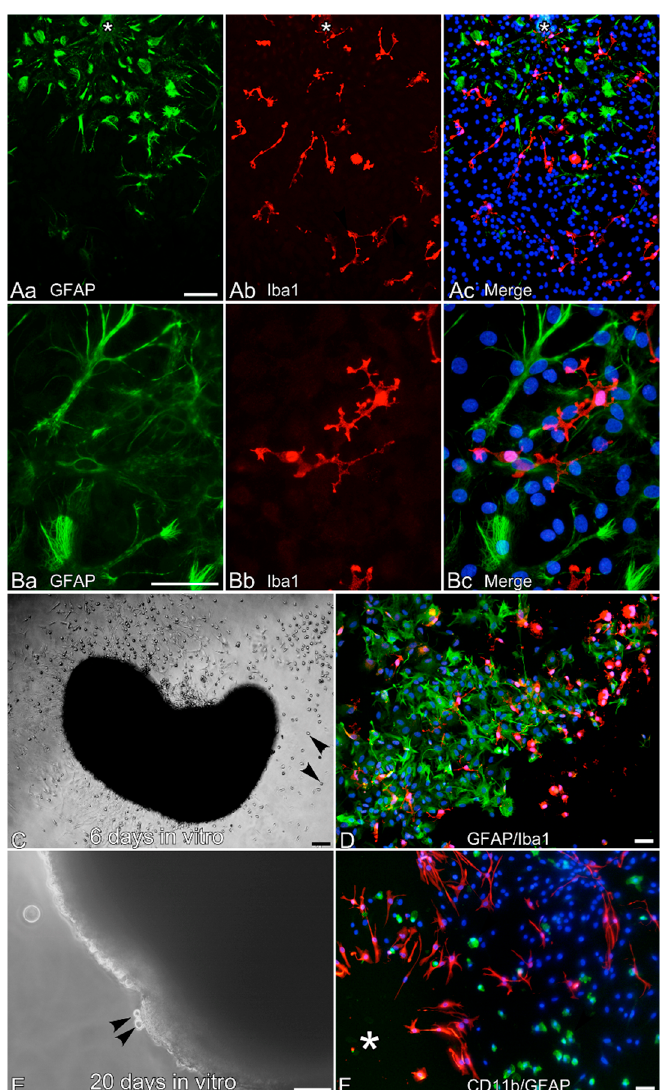
Figure 3. Generation of Iba1 + ramified microglia-like cells from leptomeningeal cells on poly-L-lysine (PLL) ‐ coated glass coverslips in Dulbecco’s modified Eagle ′ s medium containing 10% fetal calf serum (FCS-DMEM). ( A , B ) GFAP + cells (green) and Iba1 + ramified microglia-like cells (red) generated from aggregates in dissociated culture maintained in E2-EGF for 4 days. The cells were fixed and immunostained after the aggregates were cultured for 2 days in FCS-DMEM. Nuclei were stained blue by Hoechst 33258. Asterisks in ( A ) denote the place where an aggregate loosely attached before fixation. The aggregates detached during fixation, and GFAP + and Iba1 + cells migrated out of the aggregates. ( C , D ) En bloc culture of leptomeninges-generated Iba1 + cells as well as GFAP + cells. ( C ) A phase contrast micrograph shows that a large number of cells migrated out of a rounded piece of meninge cultured for 6 days in E2-EGF. Many amoeboid cells (arrowheads) came out and migrated a long distance. ( D ) Ramified, amoeboid Iba1 + cells (red) and GFAP + cells (green) generated from the rounded leptomeninges. Nuclei were stained blue by Hoechst 33258. ( E ) A piece of leptomeninges cultured for 20 days in E2-EGF still produced macrophage-like cells budding from the surface of the leptomeninges (arrowheads). ( F ) Cells derived from the cultured tissue were fixed and immunostained with antibodies against CD11b (green) and GFAP (red). CD11b + cells (green) showed only amoeboid morphology. Nuclei were stained blue by Hoechst 33258. Scale bar = 25 µ m ( A , D ), 50 µ m ( B , C ). Generated cells decreased in number with longer